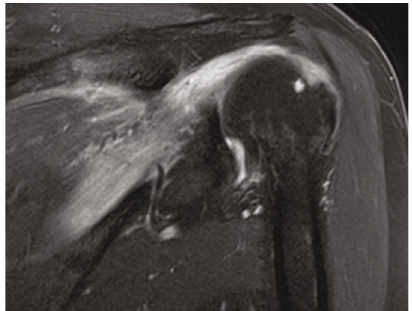
Figure 1: Coronal T2 MRI of the left shoulder demonstrating hyperintensity throughout the infraspinatus muscle, consistent with myositis.